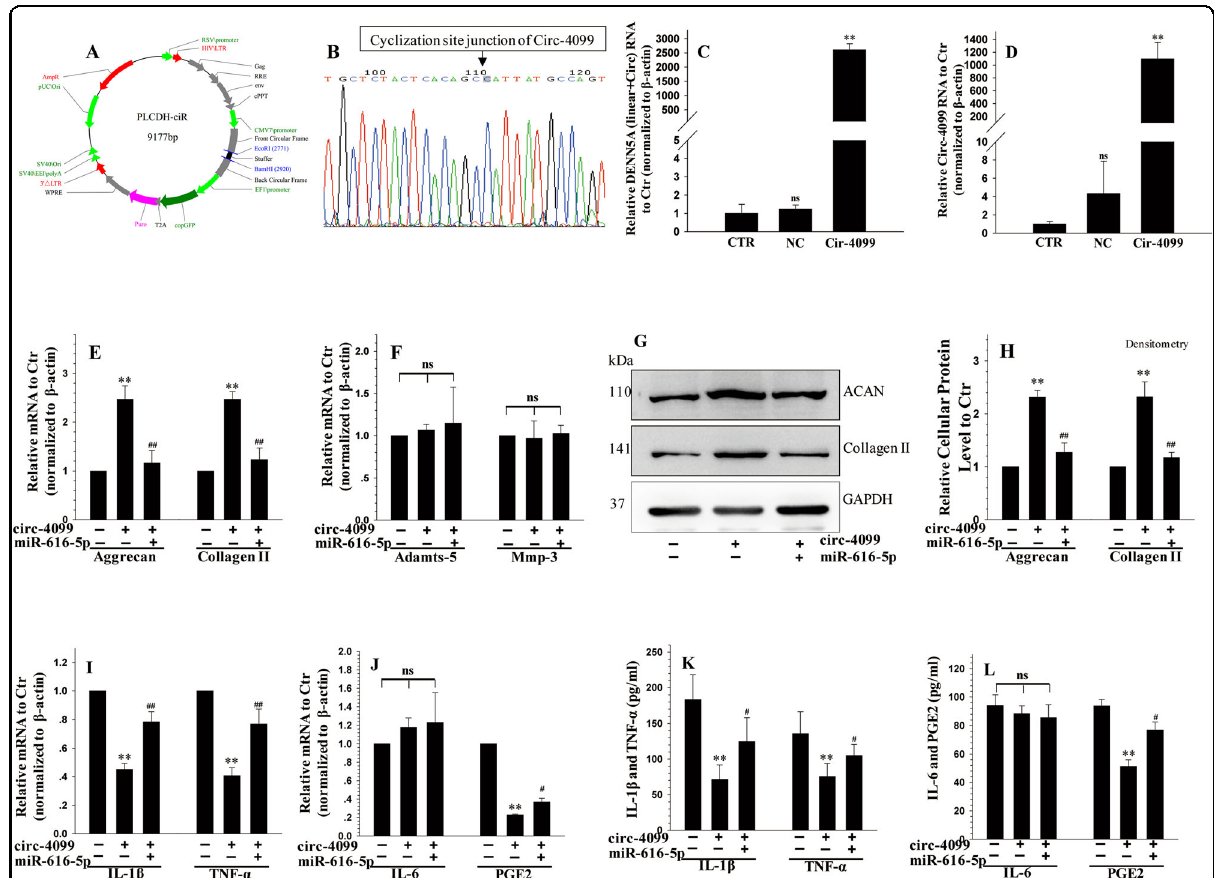
Fig. 3 The effects of Circ-4099 on the expression of extracellular matrix and in fl ammatory cytokines in hNP. a Plasmid map of the Circ-4099 over-expression plasmid. b The qPCR products were used to con fi rm the Circ-4099 sequence. c , d hNP cells were transfected with Circ-4099, NC (PLCDH-ciR) or negative control, and total RNA was collected. qPCR was used to detect the expression of Circ-4099 and its linear RNA (DENND5A) (linear + circRNA). The results showed that the Circ-4099 over-expression plasmid can extremely enhance Circ-4099 expression. These data con fi rm the validity and ef fi ciency of the Circ-4099 over-expression plasmid. e , f qRT-PCR showed that Circ-4099 over-expression led to increased Collagen II and Aggrecan mRNA expression, which was suppressed by treatment with miR-616-5p mimics, while MMP3 and ADAMTS5 showed few signi fi cant differences in regulation. g , h Western blotting also showed that he Collagen II and Aggrecan protein expression levels were signi fi cantly increased by circ-4099 over-expression treatment. We next tested the effects of Circ-4099 on expression of in fl ammatory cytokines in hNP. i , j The IL-1 β , TNF- α , and PGE2 mRNA levels were signi fi cantly suppressed in hNP cells transduced with Circ-4099 over-expression plasmid, which was inhibited by treatment with miR-616-5p mimics. k , l IL-1 β , TNF- α , IL-6, and PGE2 cytokine release into medium was detected by ELISA, which showed similar